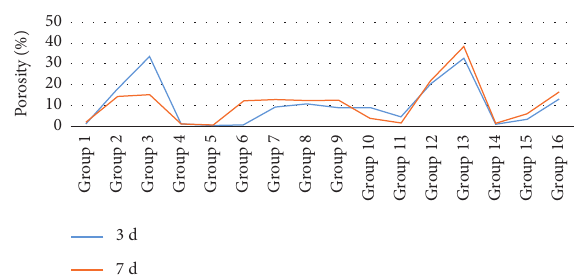
Figure 14: Change trends of the porosity.